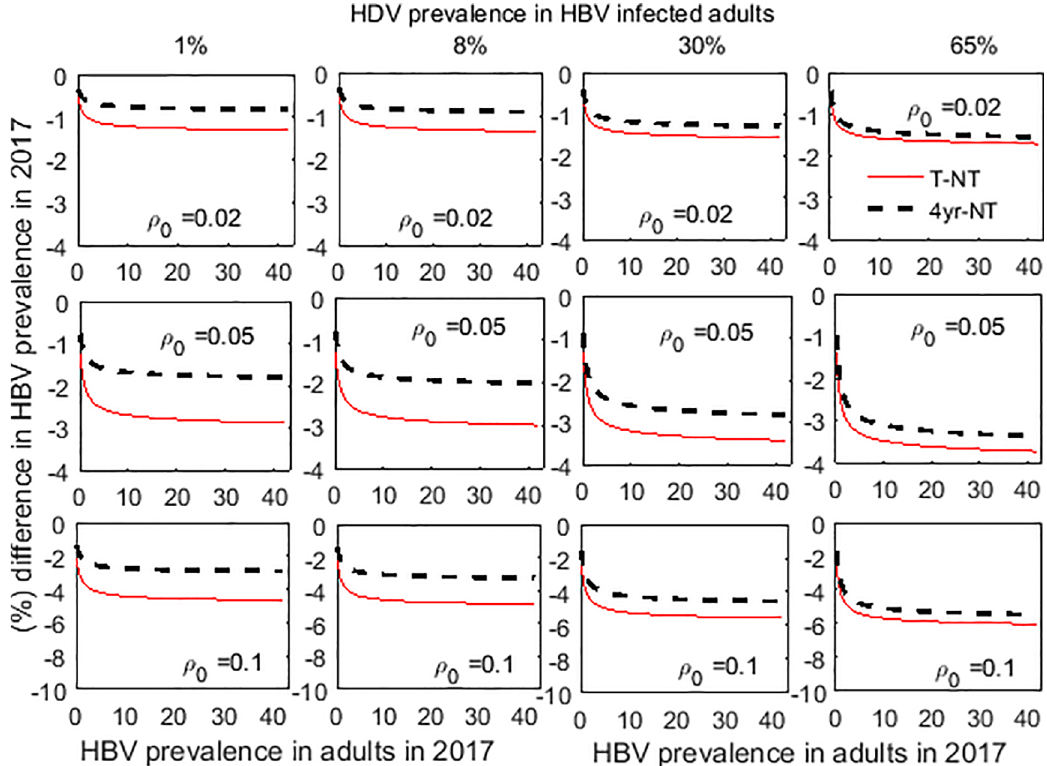
Fig 2. Impact of HDV testing on HBV prevalence according to initial HBV prevalence in adults, HDV prevalence in HBV mono-infected adults and allowed maximum screening rate of the total population. The maximum screening rate ( ρ 0 ) and HDV prevalence in HBV mono-infected individuals are varied across columns and rows, respectively while the prevalence of HBV in the population is varied on the x-axis of each subfigure. The screening rate can be interpreted as approximately the proportion of the population that can be screened each year. The black dashed line shows the reduction in hepatitis prevalence (both mono- and co-infections) from treating HBV-only with a 4-year course of TDF and co-infections with 1-year PEG-IFN, while the red line shows the effect of treating everyone with